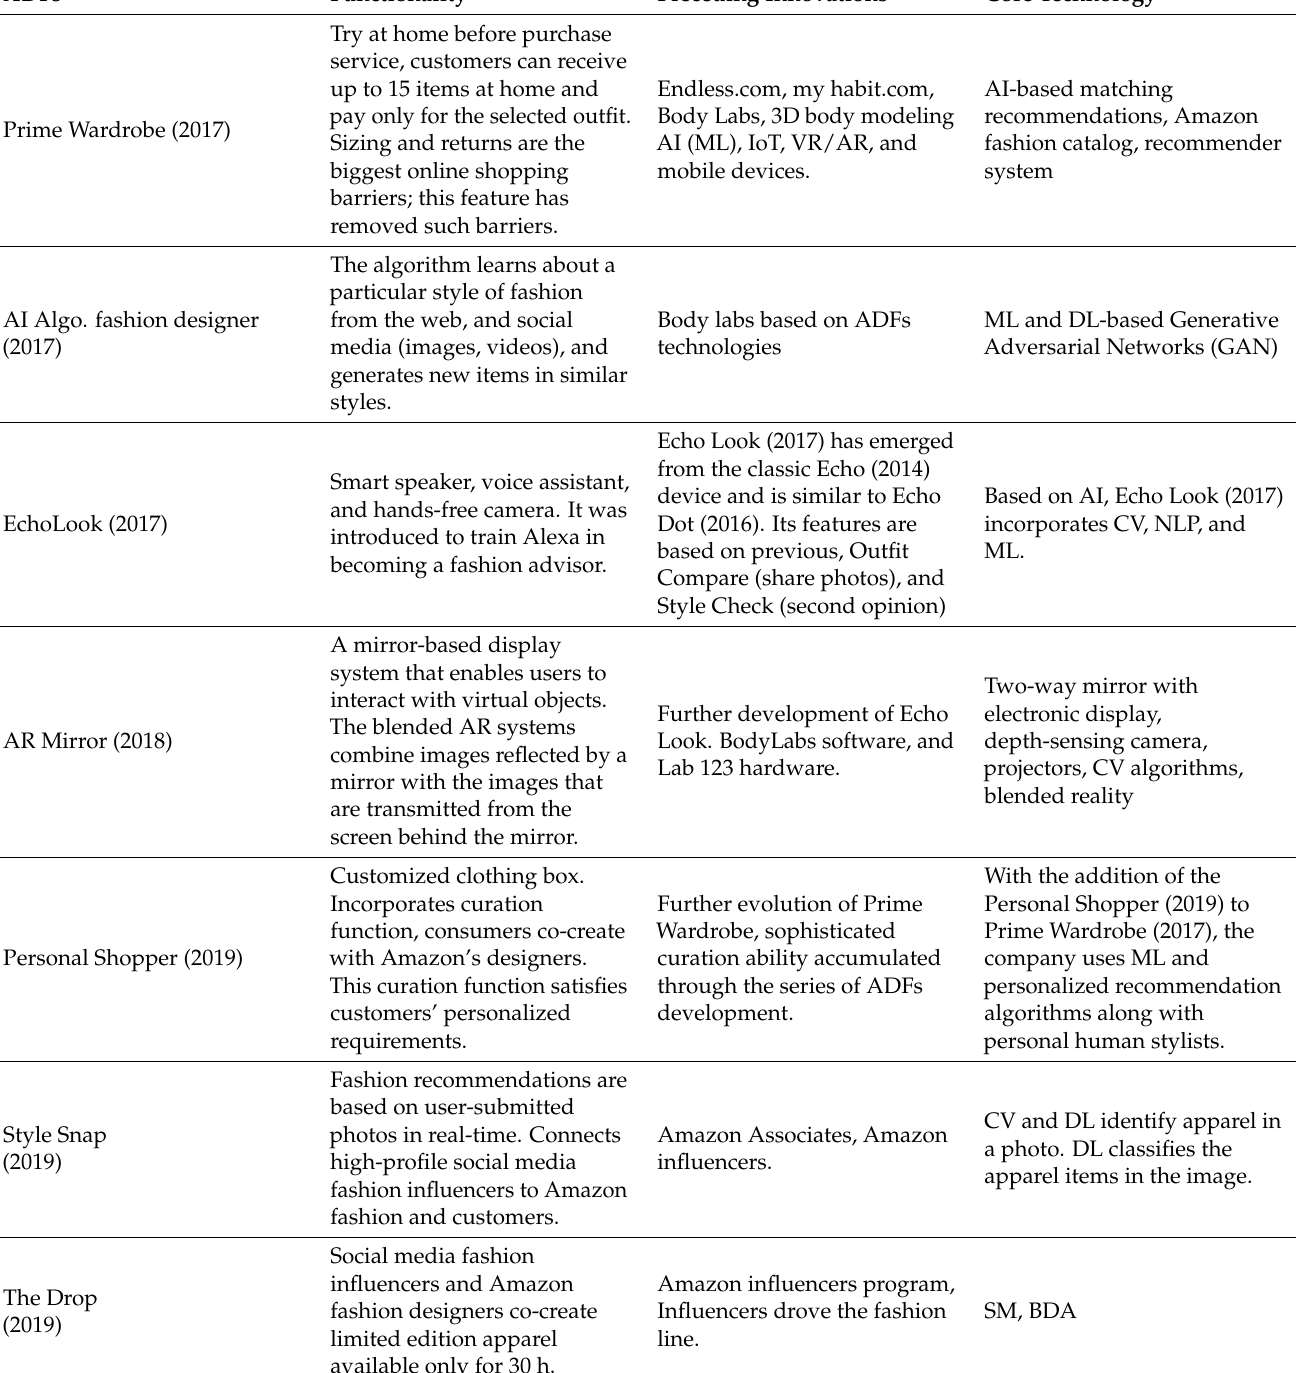
Table 1. Functions and enabling core technologies for ADFs